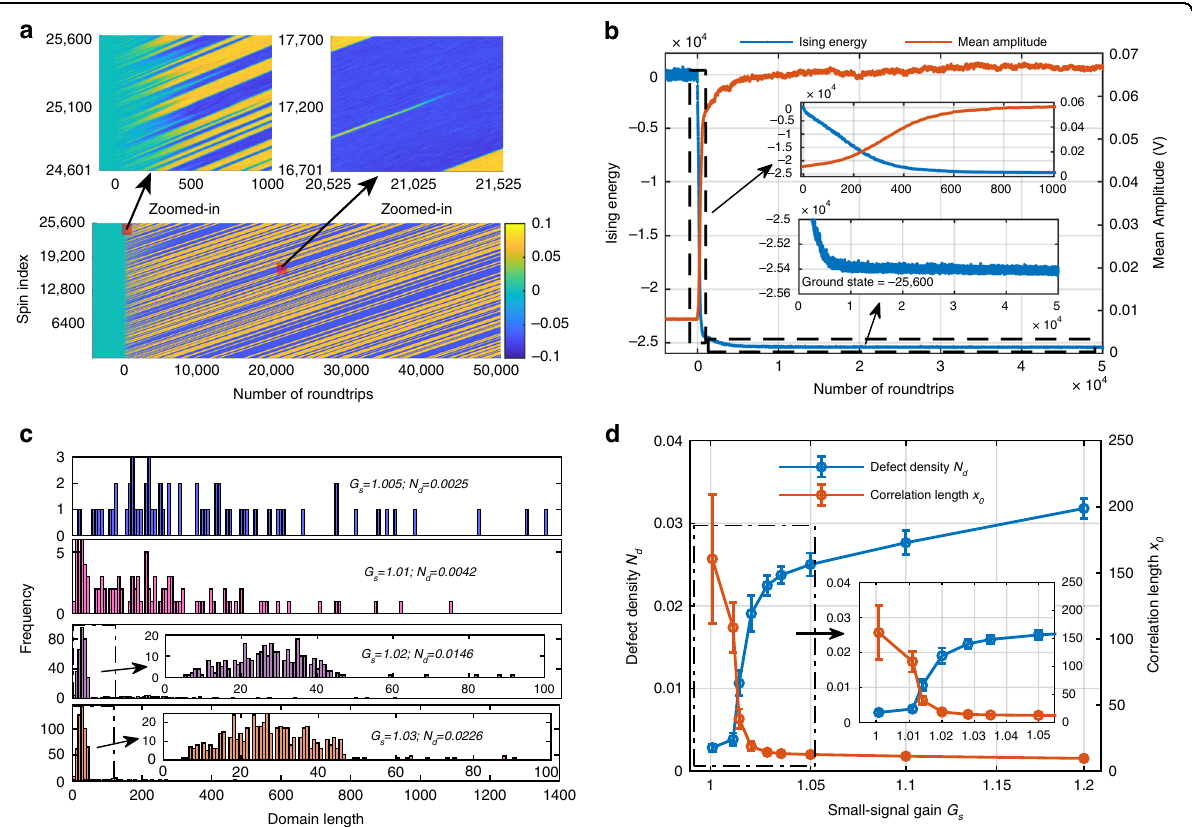
Fig. 3 The experimental results of the 1D Ising machine. a Spin evolution as a function of the number of roundtrips. The zoomed-in view on the left shows the details of the spin evolution from the noise state to a relatively stable domain. The zoomed-in view on the right shows the evaporation of the short domain. b The Ising energy and the mean amplitude of the spins as functions of the number of roundtrips. c The histograms of the domain length at different small-signal gains. At the small gain, the domain is relatively long, while the frequency of the shot domain increases at a large gain. d The defect density and correlation length as functions of the small-signal